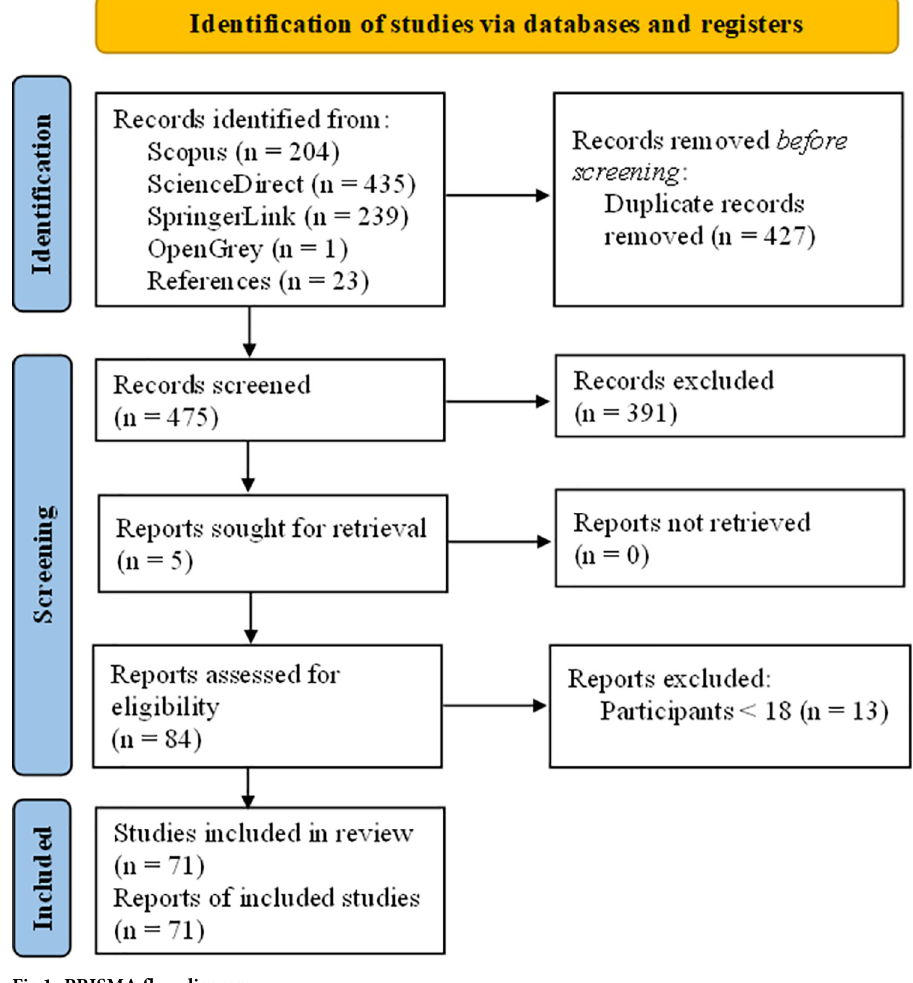
Fig 1. PRISMA flow